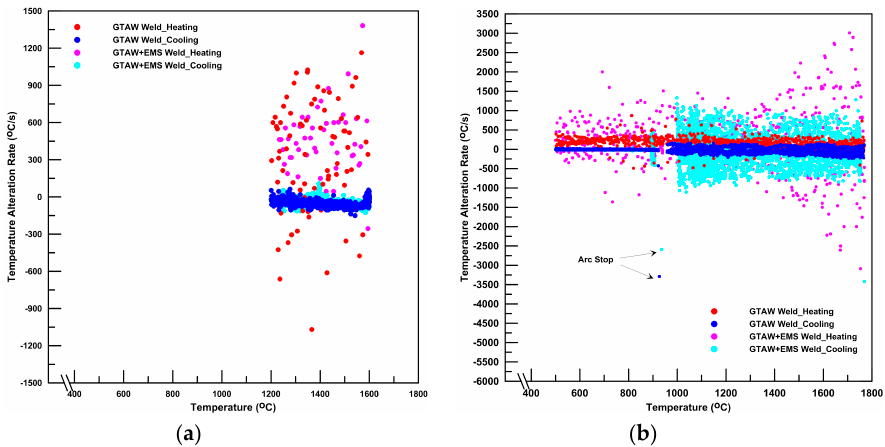
Figure 11. The relationship between the temperature and the temperature alteration rates (TARs) of the fusion zone: ( a ) high-speed pyrometer and ( b ) R-type thermocouple.